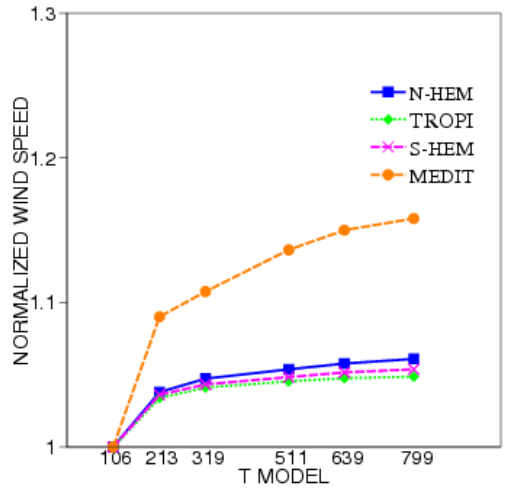
Fig. 1. Variability of the sea surface wind fields as a function of the Figure 1 – Variability of the sea surface wind fields as a function of the resolution of the ECMWF resolution of the ECMWF meteorological model (after Cavaleri and meteorological model (after Cavaleri and Bertotti, 2006). Bertotti, 2006).